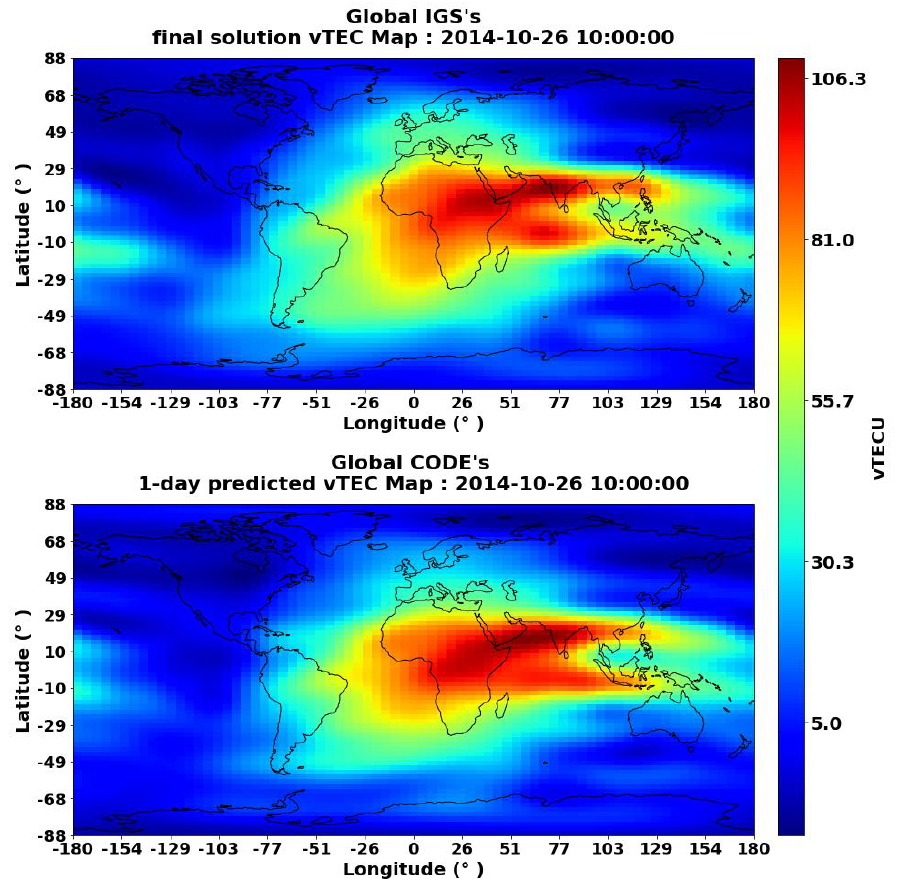
Figure 1. vTEC GIMs, ( top )—represents the final solution provided by IGS for 10-26-2014 at 10:00. ( bottom )—represents the 1-day prediction provided by CODE for 10-26-2014 at